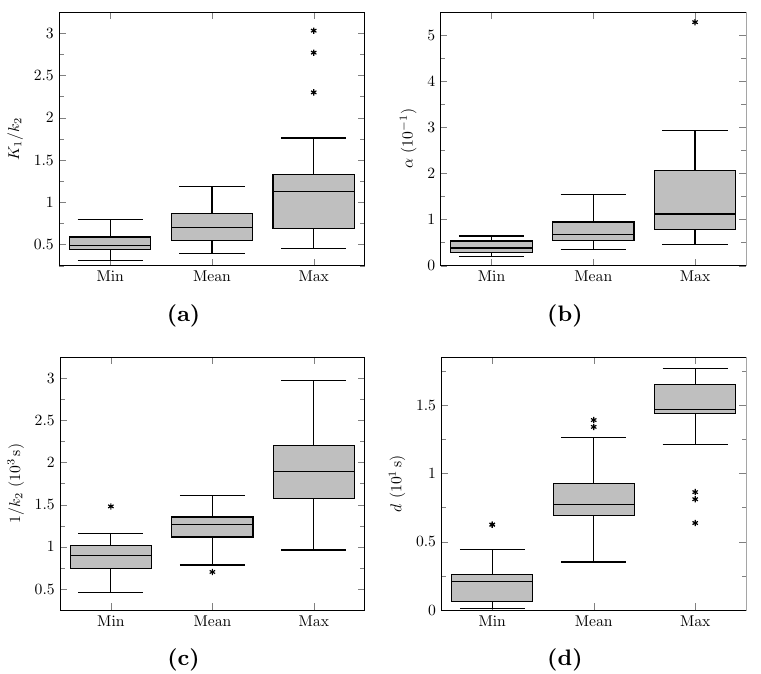
Figure A4. Distribution of the minimum, maximum, and mean kinetic parameter values within the BTV in Table A4 for lesions with a non-zero BTV summarized by means of boxplots (horizontal line: median, box: interquartile range, whiskers: ± 1.5 interquartile range, *: outliers). ( a ): K 1 / k 2 . ( b ): α . ( c ): 1/ k 2 . ( d ): d .